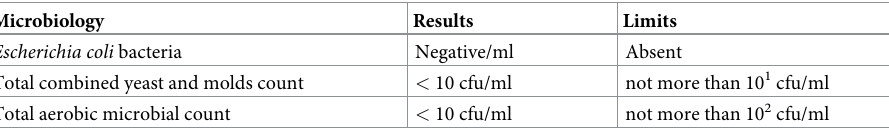
Table 3. Microbial limit tests after 28 days of storage at room